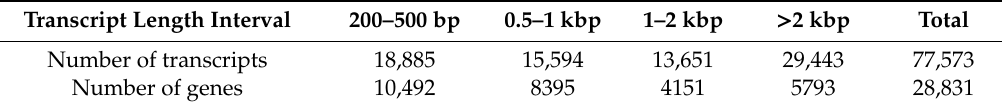
Table 1. List of distribution of stitching length and frequency.